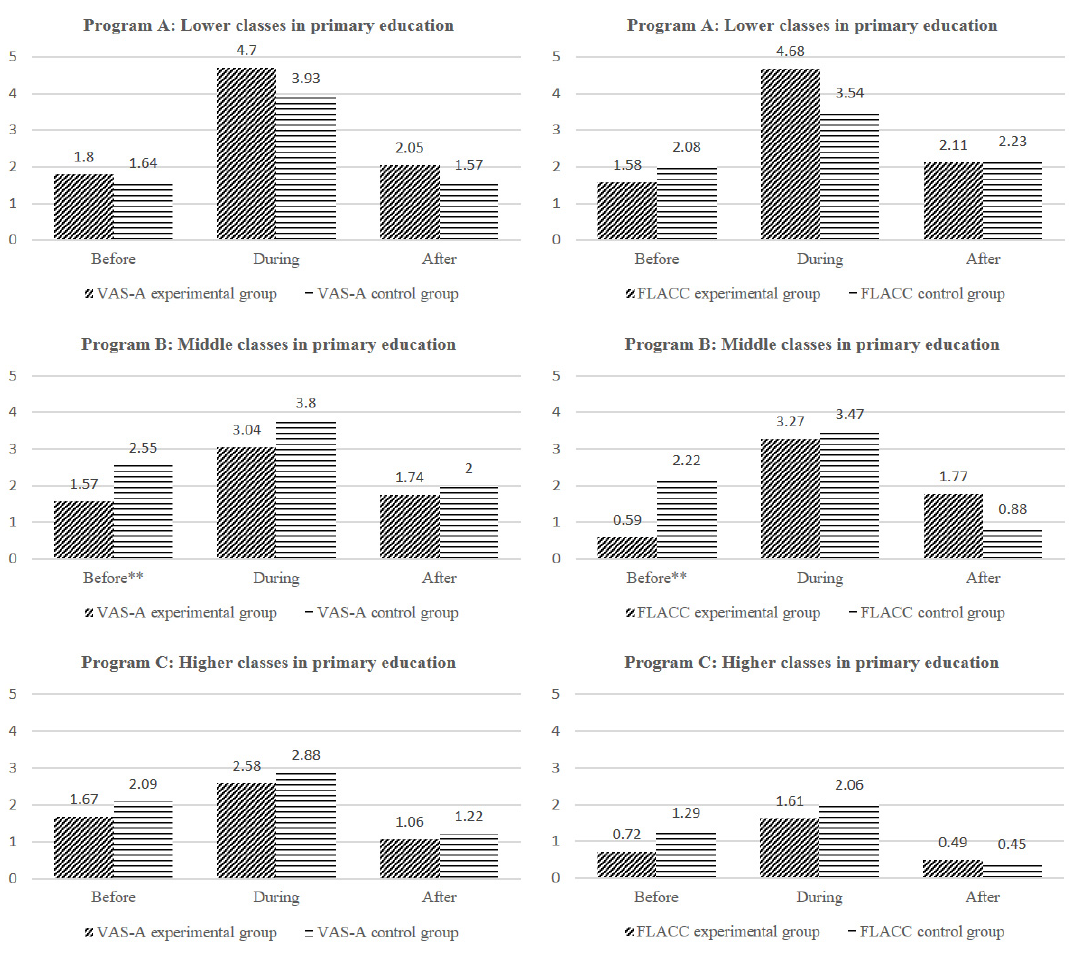
Figure 2. VAS-A and FLACC scores before, during, and after based on program/target group (** 𝑝 < 0.01 ). Table 4. VAS-A scores provided by the children.